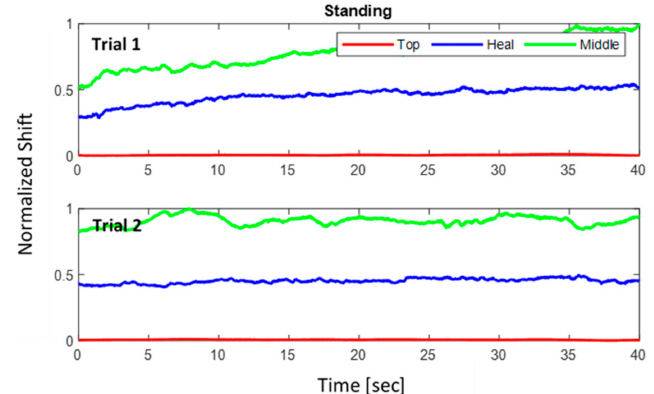
Figure 25. Standing posture normalized shift for 2 trials of a single participant.